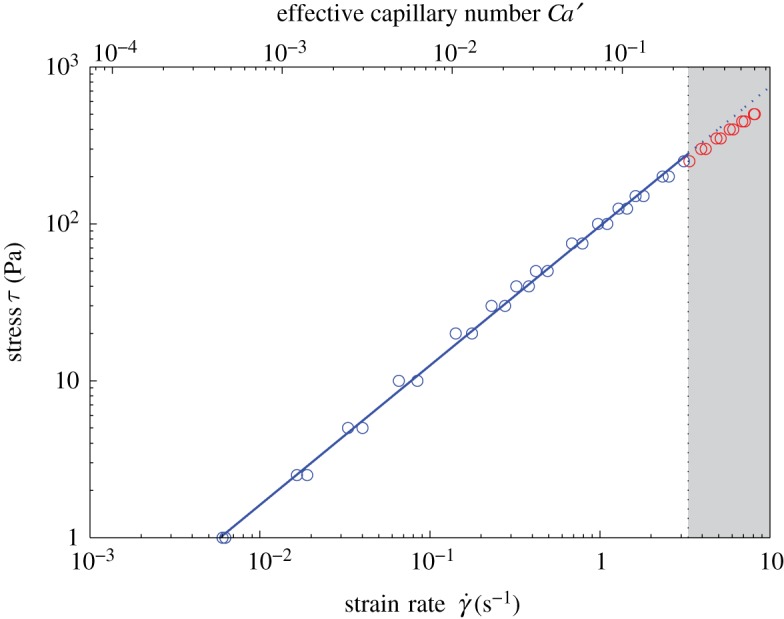
Flow curve of shear stress τ against shear strain-rate γ˙ for sample 3P-30 with ϕb=0.30 and ϕp=0.04. Datapoints are collected during both the up-ramp and down-ramp (§4b). Datapoints are discarded (shaded region) for Ca′ (defined in §4c) greater than the upper bound of the low-capillarity region, defined according to equation (4.2); for ϕb=0.30, this is Ca′≥0.248. Solid line is the best fit of equation (4.3) to the remaining datapoints, giving ηr,*=1.74 and n=0.89; dashed line is the fit extended into the discarded region. (Online version in colour.)